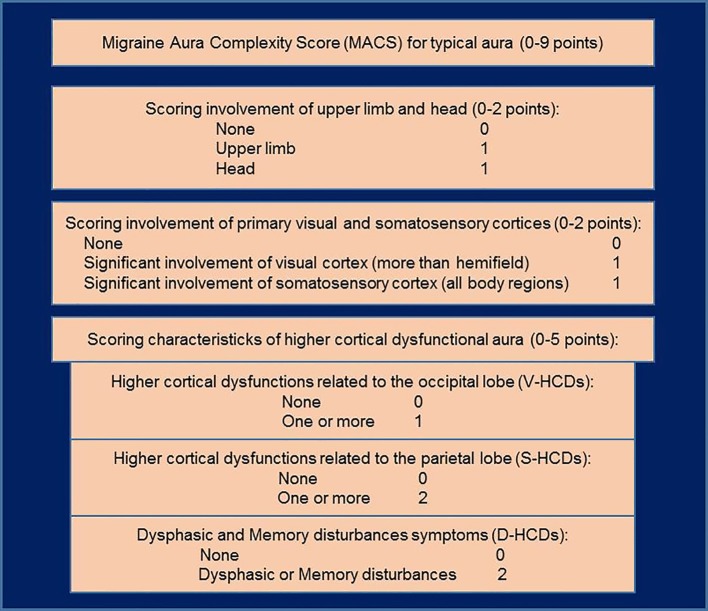
Schema of the Migraine Aura Complexity Score (MACS). Higher cortical dysfunctions of occipital cortex (V-HCDs): micropsia, macropsia, dysmorphia, fractured vision, and prosopagnosia; higher cortical dysfunctions of parietal cortex (S-HCDs): astereognosis, dyspraxia, and unawareness of one's own body parts; dysphasic and memory disturbances symptoms (D-HCDs): (Broca's dysphasia, Wernicke's dysphasia, dysnomia, dyslexia, difficulties in remembering or recalling events, recalling names, and calculating and/or memorizing numbers). Adapted from our previous research paper (14).